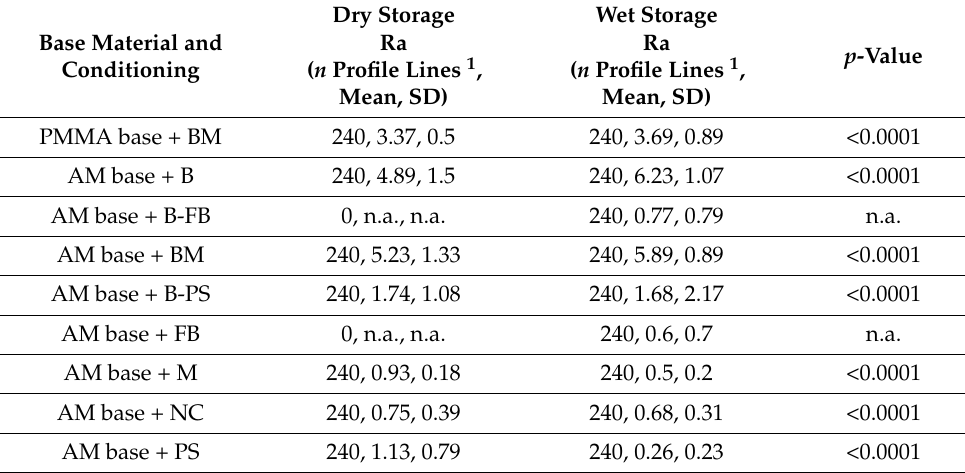
Table 1. Surface roughness of the bonding interfaces at the base material in dry and wet condition. Statistical comparison by Wilcoxon Rank sum test and one-way chi-square approximation. (“n.a.” indicates groups that are not existent due to the study